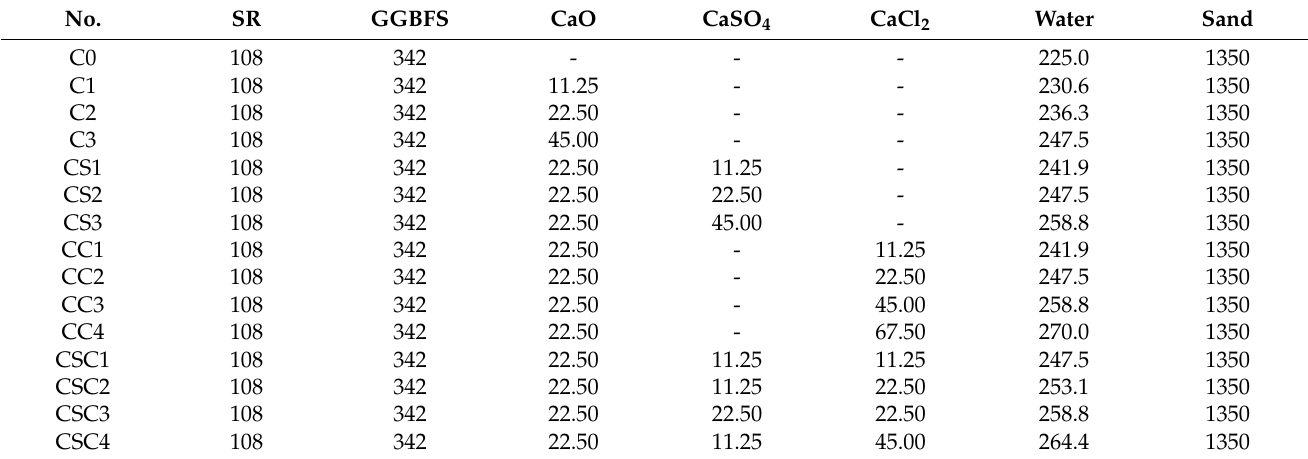
Table 5. Group III, mixing proportions of SR-activated GGBFS mortars